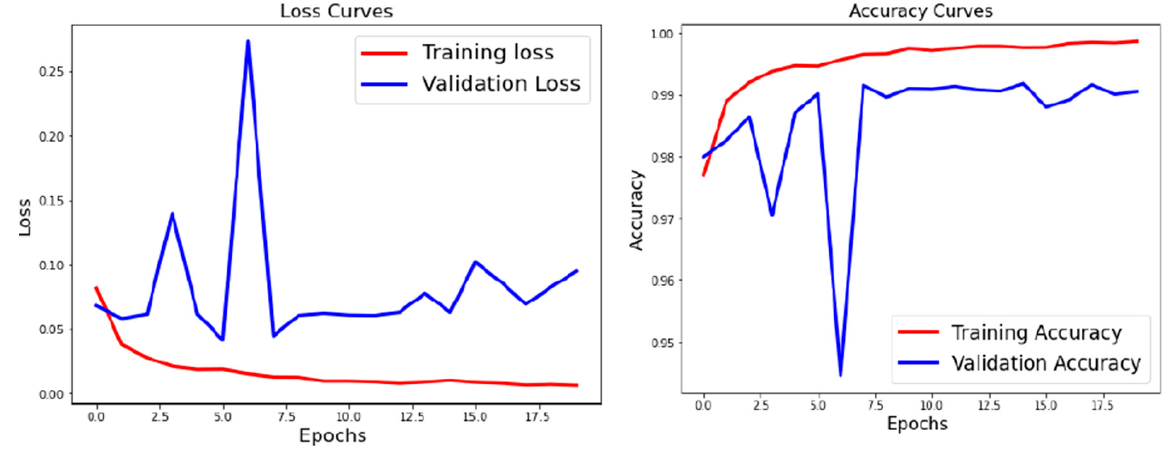
Figure 6. Graphs of the loss and accuracy curves for the feed-forward network.